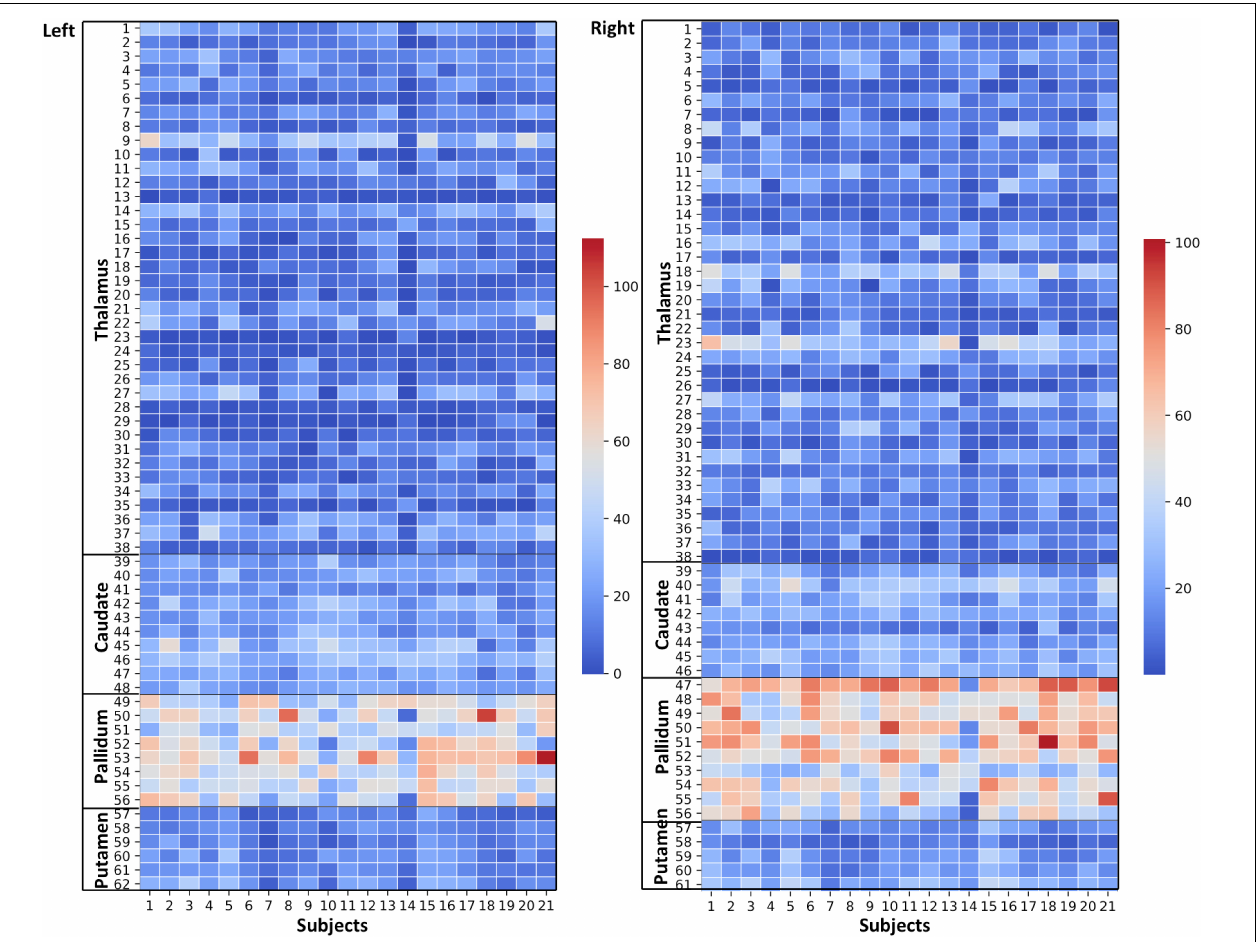
FIGURE 6 | Effects of paramagnetic sources (iron) in Th and BG: Left hemisphere : Mean diamagnetic source values for all parcels in all subjects. Each column represents each subject. Each row represents a functional parcel. The total number of ICP functional parcels are 62, i.e., Th (38) + caudate (10) + pallidum (8) + putamen (6). Note the higher mean values in pallidum and some of Th parcels compared to other structures. Right hemisphere : Mean diamagnetic source values for all parcels in all subjects. Each column represents each subject. Each row represents a functional parcel. The total number of ICP functional parcels are 61, i.e., Th (38) + caudate (8) + pallidum (10) + putamen (5). Note the higher mean values in pallidum and some of Th parcels compared to other